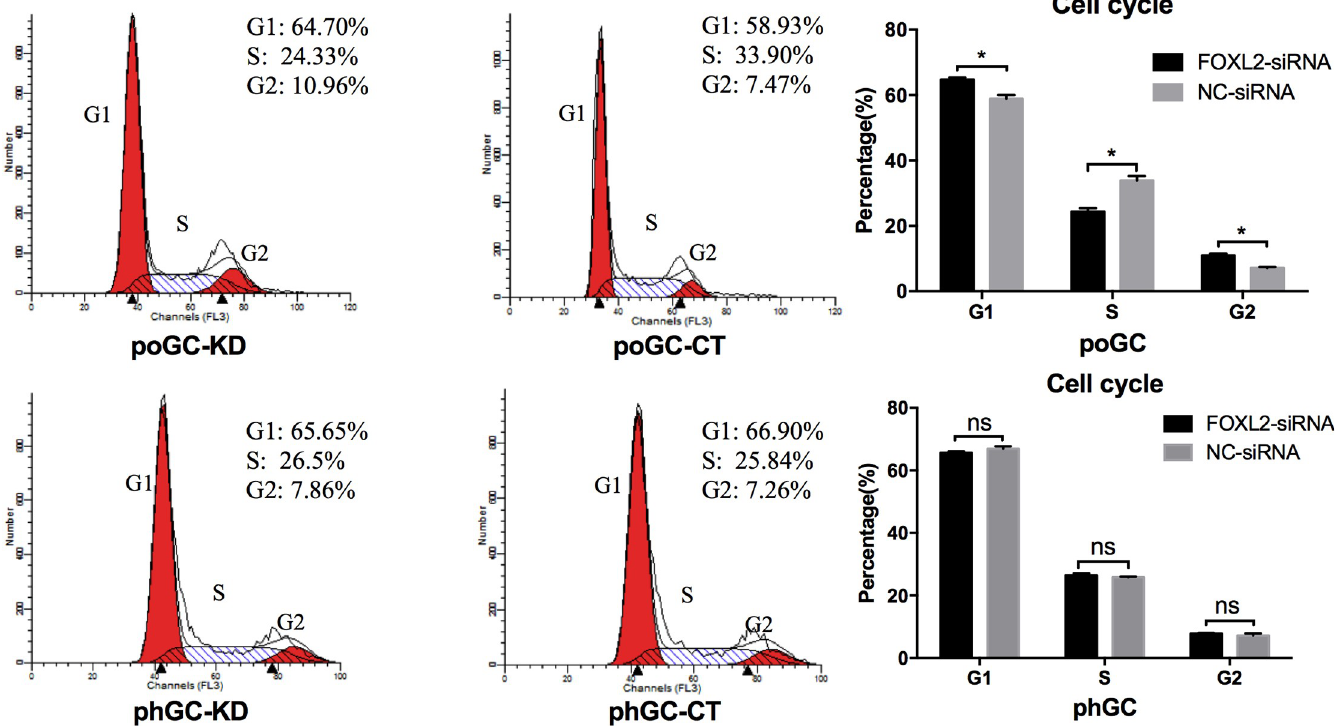
Fig 9. The effect of knocking down FOXL2 on the cell cycle in chicken granulosa cells. PoGC and phGC were transfected with FOXL2-siRNA or NC-siRNA, and the distribution of cells by cell cycle phase was analysed using a flow cytometer 48 h post-transfection. Three independent experiments were repeated in triplicate. All the values are presented as the mean ± SD. The asterisks represent statistically significant differences ( � indicates P < 0.05; ns indicates not significant).